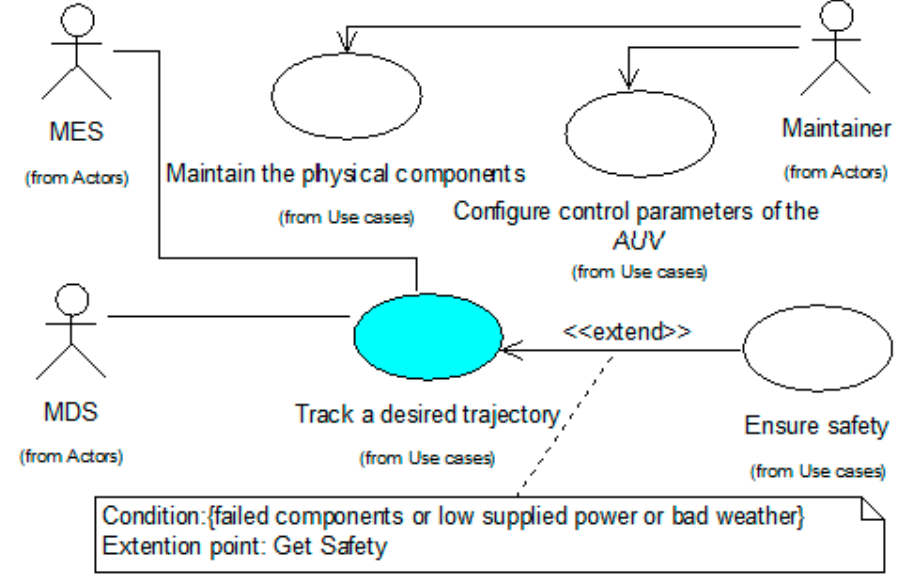
Figure 2. Use case model of the developed AUV.